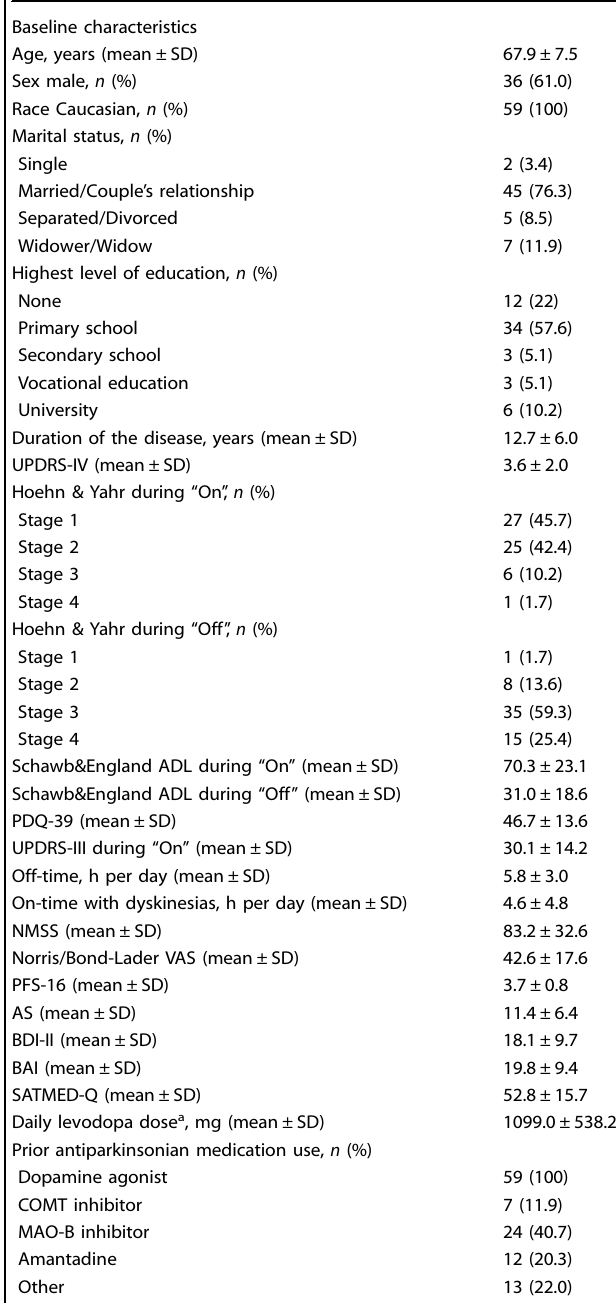
Table 1. Clinical and socio-demographic characteristics of the patients, at